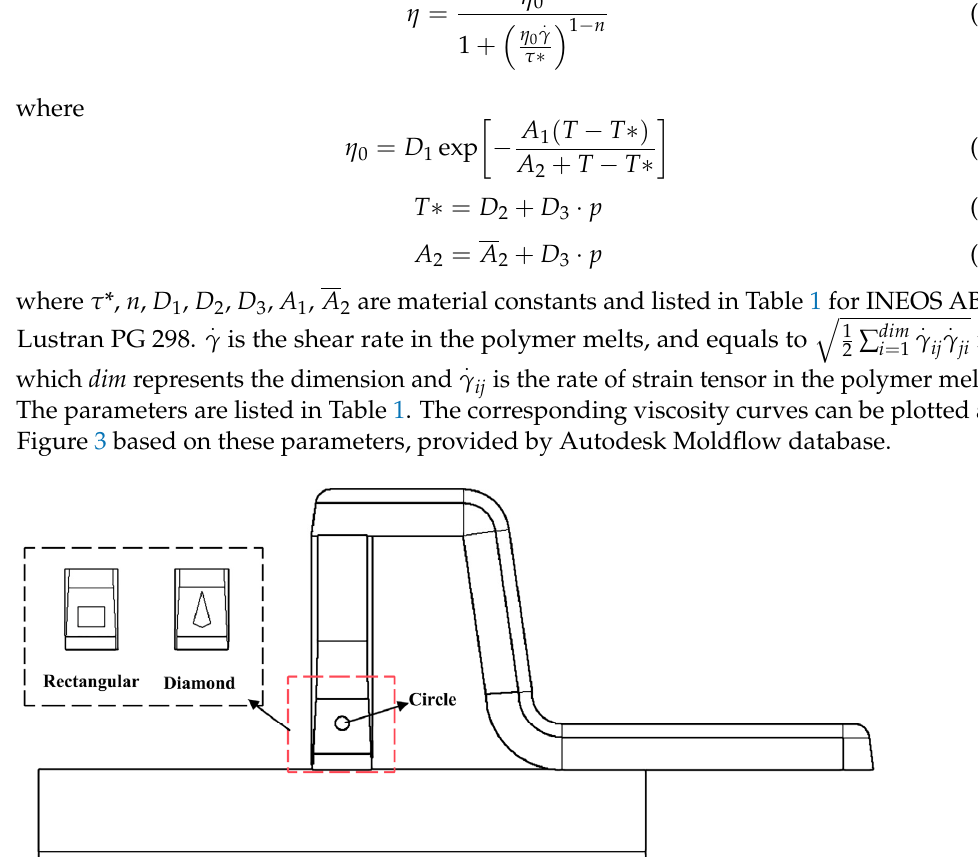
Figure 1. Geometry and the dimensions of the plastic part without insert close the gate.